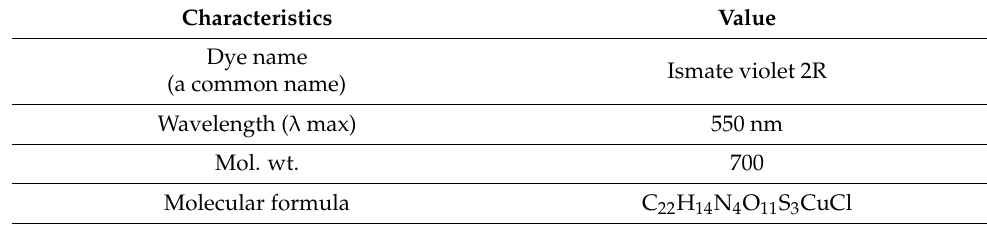
Table 1. characteristics of physical and chemical for ISMATE violet 2R [30]. Characteristics